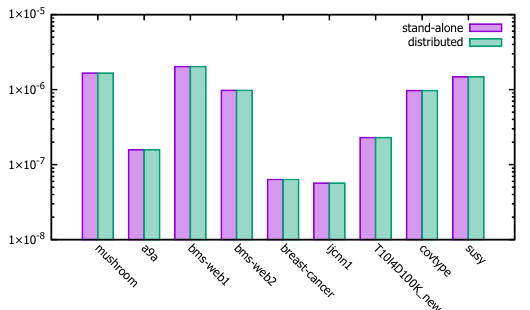
Figure 15. Modified significance thresholds for different datasets of